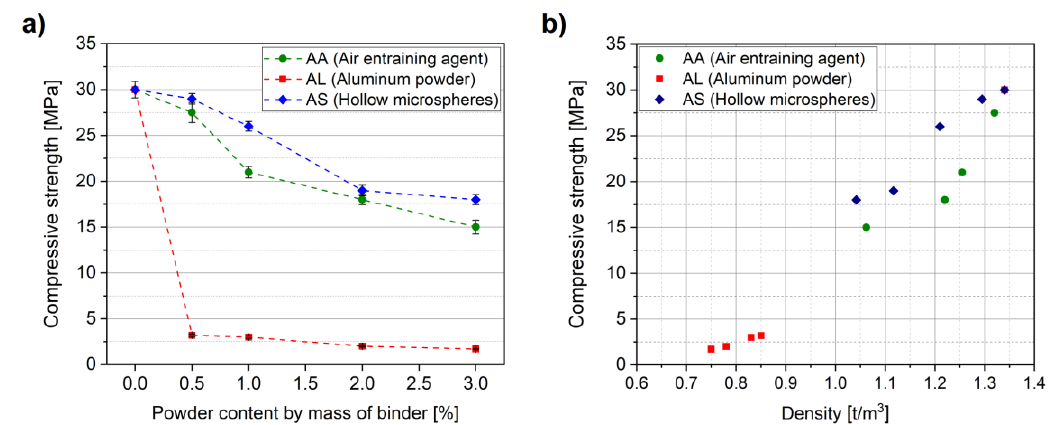
Figure 3. Compressive strength of the specimens with different additives: ( a ) compressive strength vs. powder content; ( b ) compressive strength vs. density.